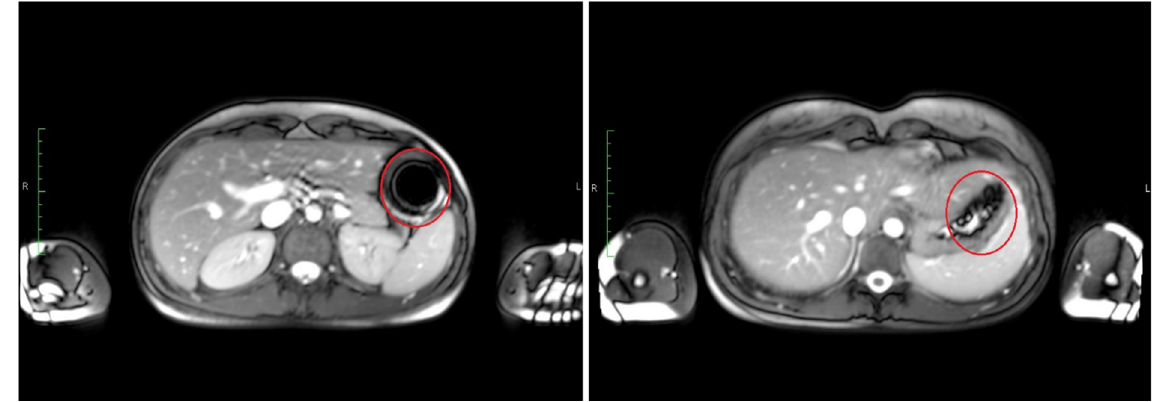
Figure 3. Transversal images of T2*/T1 weighted TRUFI with an intact susceptibility artifact of iron oxide at 10 min ( left ) and the same artifact after disintegration at 30 min ( right ).